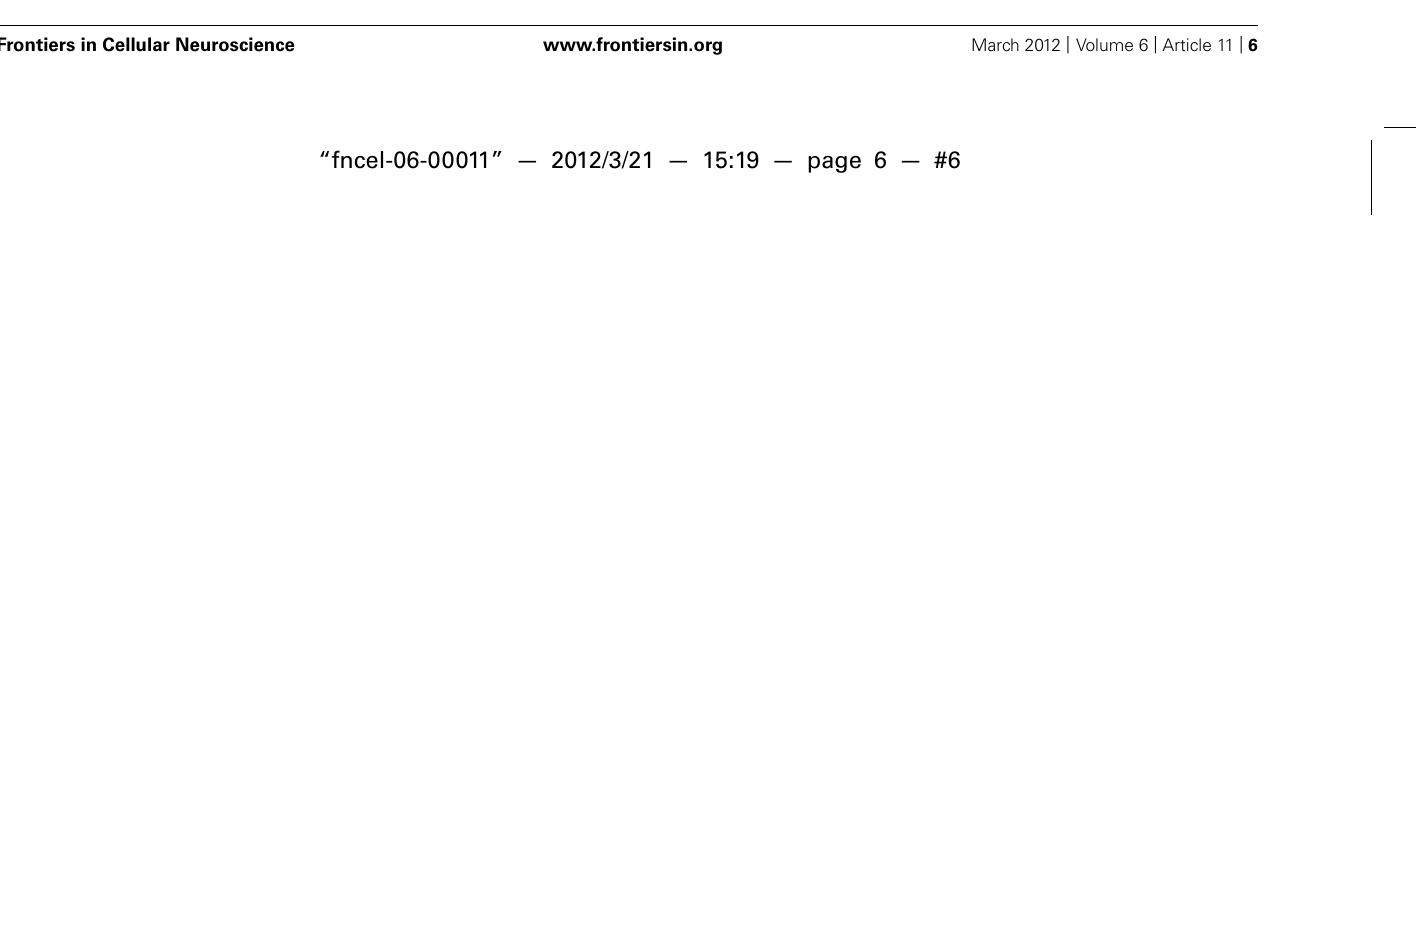
GFP + cells away from the main graft core showed neurons with various profiles including multipolar-stellate (B) and pyramidal (C) morphology as well as various glial morphologies ( D ; cells in corpus callosum) and cells resembling migrating neuroblasts ( E ; arrowheads show neuroblast proximal to graft core situated toward top-right corner). Scale bars: (A) 2 mm, (B–E) 50 μ